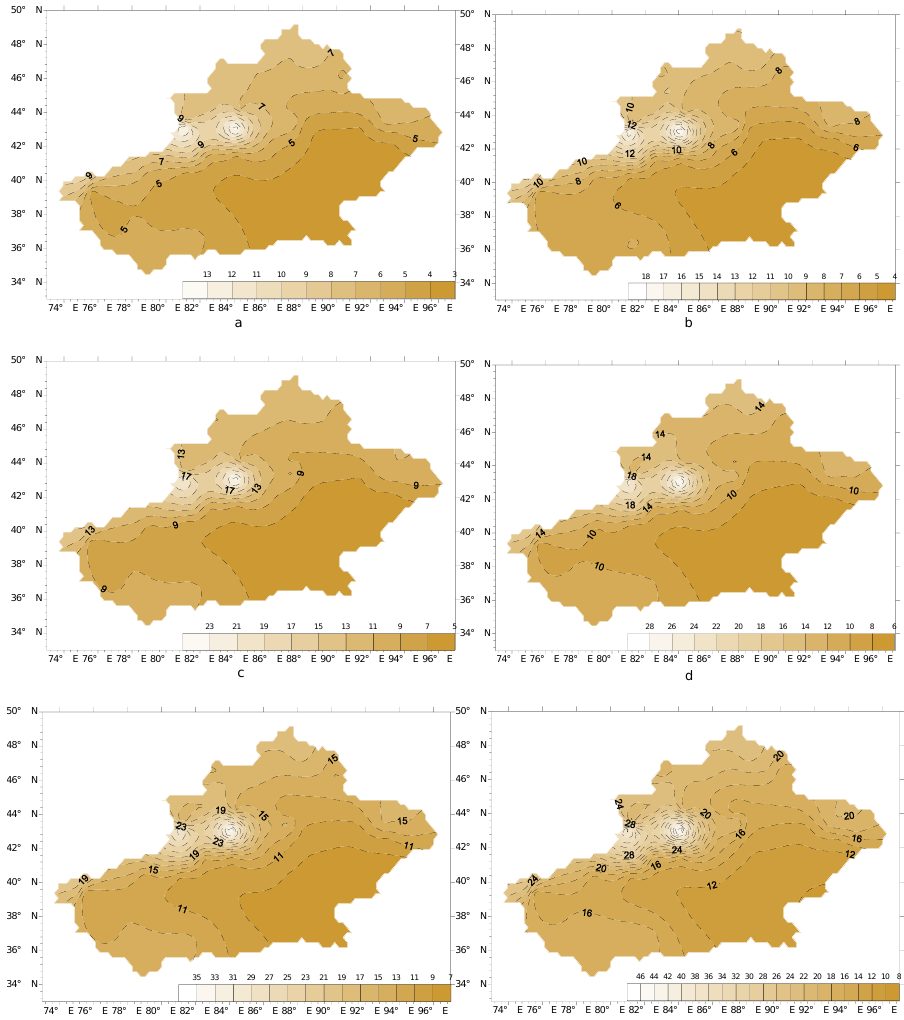
Figure 9 Fig. 9. Spatiotemporal distribution of estimated CWD over Xinjiang for various recurrence intervals: (a) 5yr; (b) 10yr; (c) 20yr; (d) 30yr;